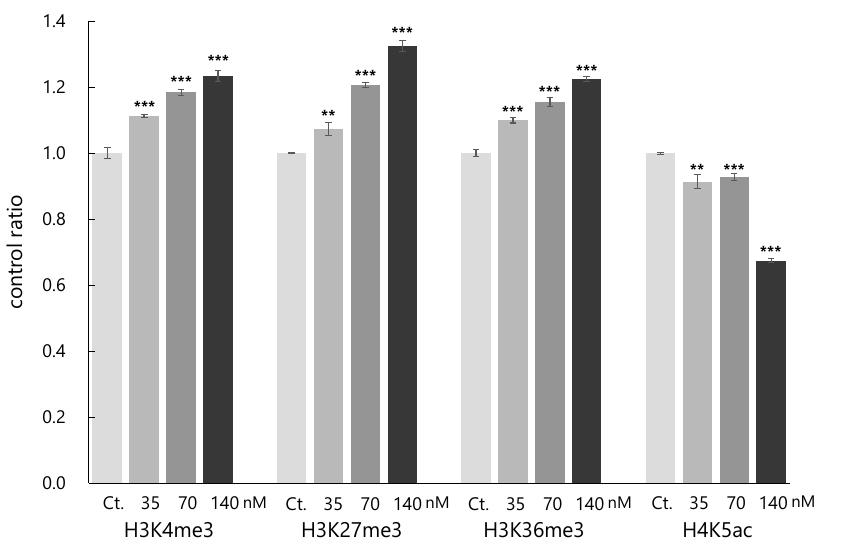
Figure 4. Effects of onnamide A ( 3 ) on histone modifications. Quantification of the histone modification levels of H3K4me3, H3K27me3, H3K36me3 and H4K5ac after cultivation in medium containing samples for 20 h (samples: 35, 70 and 140 nM of 1 , Ct.: DMSO, n = 3, mean ± S.D. ***: p < 0.001, **: p < 0.01, Dunnett test).